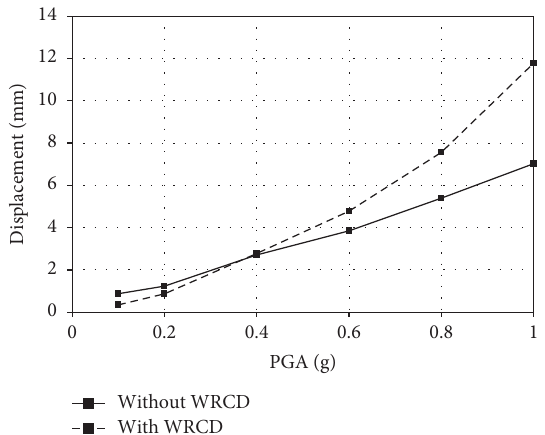
Figure 12: Te maximum displacement of 1# sliding pier top.